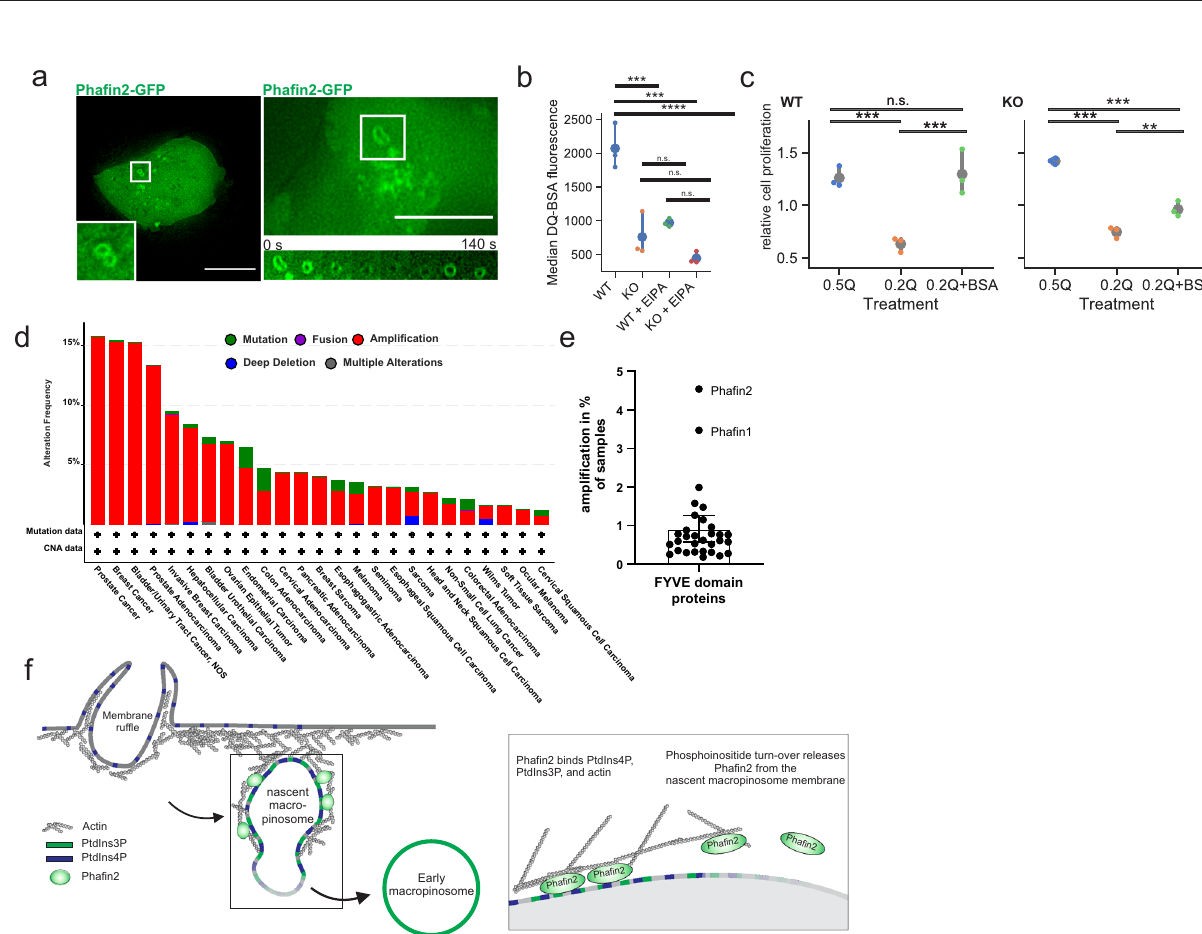
Fig. 7 Pha fi n2 can bind to actin. a Confocal images showing the effect of Pha fi n2 depletion on the actin cytoskeleton. Representative image of the data scored in Fig. 7b. Scale bar: 10 µ m. b Depletion of Pha fi n2 results in an increased number of cells with membrane ruf fl es, which can be rescued by expression of siRNA-resistant Pha fi n2. Data derived from high content imaging (2038, 1581, 1831, 2055 cells for siSCR, siPha fi n2, siSCR(Rescue) and siPha fi n2(Rescue) in total. n = 3 experiments, mean + 95% CI, two-sided t -test, p = 0.0017 (Control), p = 0.017 (Rescue). c Western blot showing in vitro actin-binding assays of MBP-Pha fi n2 and Pha fi n2 mutants. Pha fi n2 and the isolated Pha fi n2 PH domain co-sediment with actin. MBP or the isolated Pha fi n2 FYVE domain does not co-sediment. d Quanti fi cation of the in vitro actin-binding assays. n = 3 experiments, mean + 95% CI, ANOVA with Tukey ’ s post- test, p = 0.0009 (MBP vs Pha fi n2), p = 0.0073 (MBP vs. Pha fi n2 PH), p = 0.91 (MBP vs Pha fi n2 FYVE). e Images showing the effect of GFP, Pha fi n2-GFP, and Pha fi n2 Δ C-GFP expression in RPE1 cells expressing Lifeact-SNAP. Representative image of 30 cells each. Arrowheads indicate cell retractions/ membrane blebs; arrows indicate fl at cell protrusions. Scale bar: 10 µ m. f Time-lapse images of cells expressing Pha fi n2 Δ C before and after incubation with the PI4K inhibitor GSK-A1. Scale bar: 10 µ m. g Quanti fi cation of membrane blebbing after treatment of Pha fi n2 Δ C-expressing cells with the inhibitor GSK- A1. n = 81 cells. Two-sided Fisher ’ s exact test, p < 0.0001. h Time-lapse images of cells expressing light-dimerizable Pha fi n2 (Pha fi n2-mCherry-SSBP and Venus-iLID-CAAX) and Lifeact before and after light-induced plasma membrane recruitment. Arrowheads indicate membrane blebs, arrows cell retraction. Representative image of 25 cells. Scale bar: 10 µ m. i Quanti fi cation of cell retraction after light-induced membrane recruitment of Pha fi n2. n = 28 cells, two- sided Fisher ’ s exact test, p < 0.0001. j Quanti fi cation of membrane blebbing after light-induced membrane recruitment of Pha fi n2. n = 28 cells, two-sided Fisher ’ s exact test, p < 0.0001. k Time series showing a forming and retracting membrane bleb — visualized by membrane-recruited Pha fi n2-and Lifeact after Pha fi n2 membrane recruitment. Scale bar: 10 µ m. l Line plots showing intensities of membrane-recruited Pha fi n2 and Lifeact over time. Statistics source data for b , d , g , i , j , and l are provided in this paper.